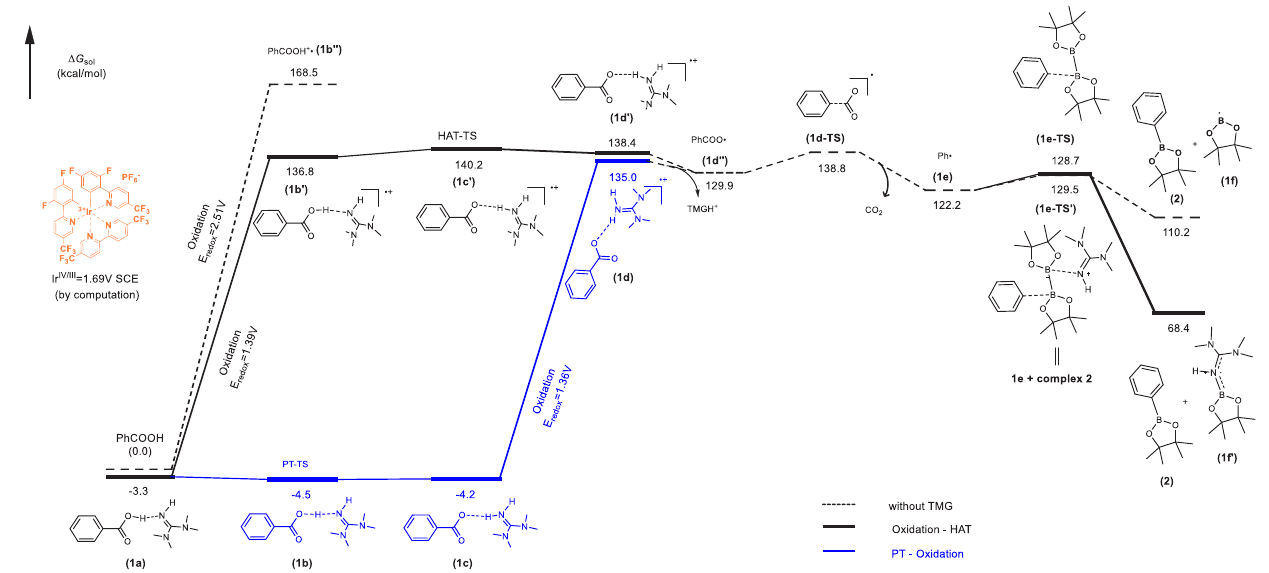
Fig. 5 | DFT-calculated reaction energy pro fi le. Free energy pro fi le for the activation of benzoic acid with (solid lines) and without (dashed lines) TMG computed with B3LYP-D3/6-311+G(d,p) scrf=(smd, solvent=ethyl-ethanoate) 65,66 . HAT hydrogen atom transfer, PT proton